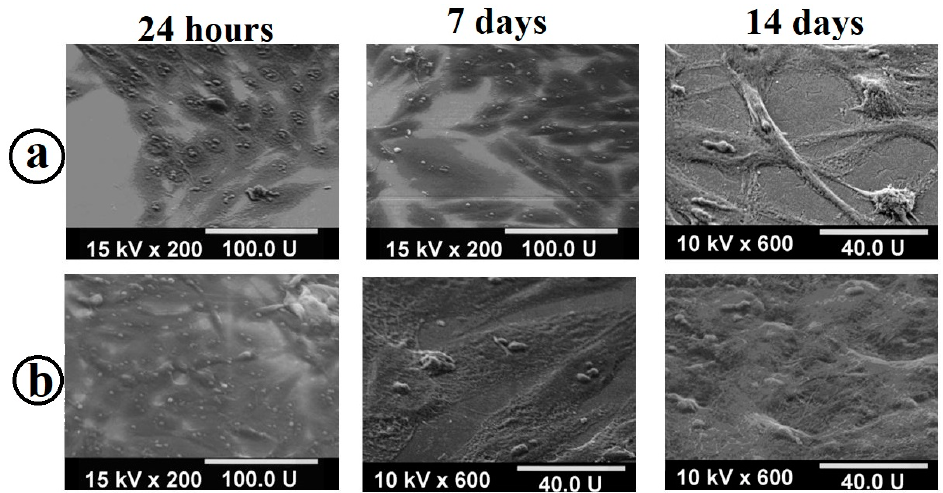
Figure 9. SEM images for the samples after adhesion and spreading of the human MG-63 cell line: ( a ) on polished titanium; and ( b ) on the sample with the TiO 2 /Ag/HAp coating.